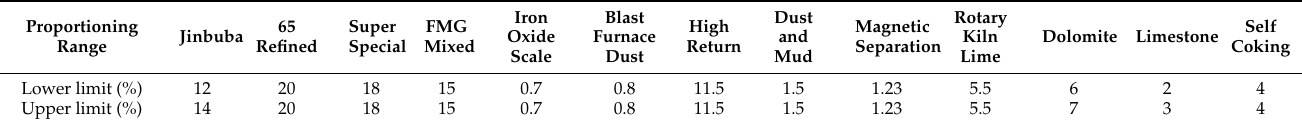
Table 4. Upper and lower limits of sintering raw material ratio.